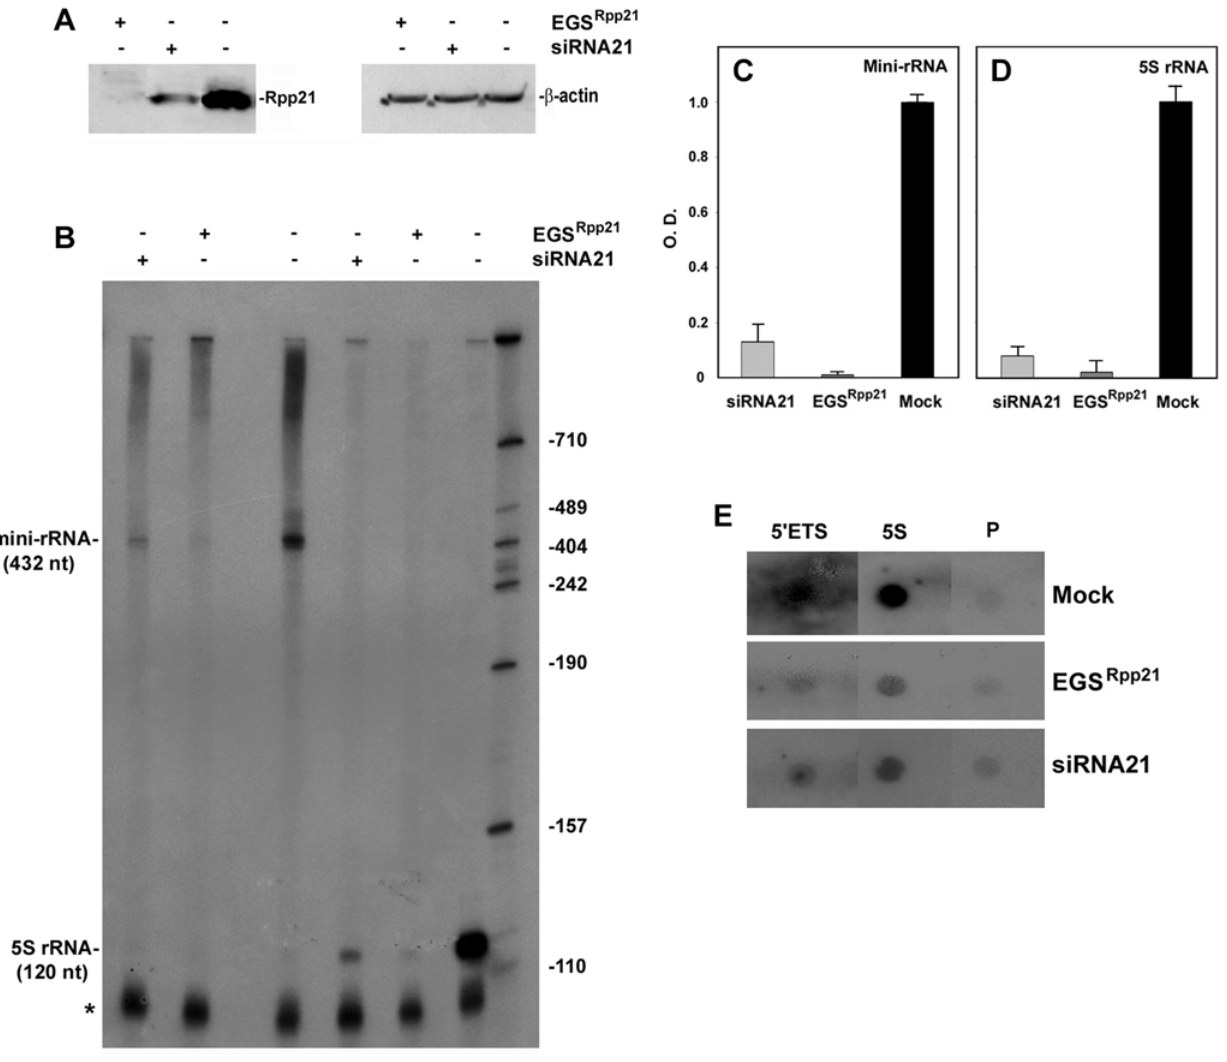
Figure 2. Knockdown of the specific subunit Rpp21 inhibits transcription and pre-rRNA synthesis. A. HeLa cells were transfected with a plasmid expressing EGS Rpp21 or siRNA21 or mocked transfected for 48 h. Whole HeLa extracts were then prepared and tested for the presence of Rpp21 and b -actin by Western blot analysis. B. Transcription of the mini-rRNA and 5S rRNA genes in extracts described in A and the reaction products were analyzed as in Figure 1C. C and D . The bands of the mini-rRNA and 5S rRNA were quantitated and plotted. E. Nuclear run-on transcription analysis (see Material and Methods) of the human 5 9 ETS rRNA and 5S rRNA genes in mock-, EGS Rpp21 - or siRNA21-treated HeLa cells. Letter P indicates pBluescript